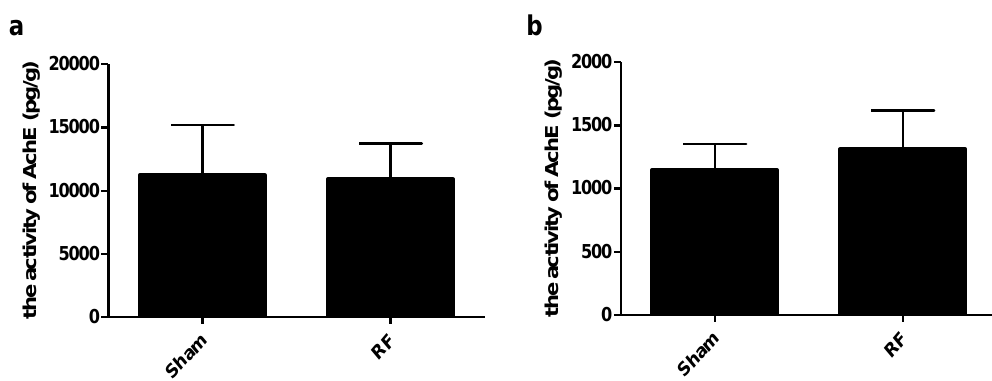
Figure 9. Effects of RF exposure on the activity of AchE in hippocampus and cortex. ( a ) hippocampus (t = 0.172, df = 12, P = 0.867), ( b ) cortex (t = 1.178, df = 12, P = 0.262). No significant difference was observed between the sham and RF groups ( P > 0.05).